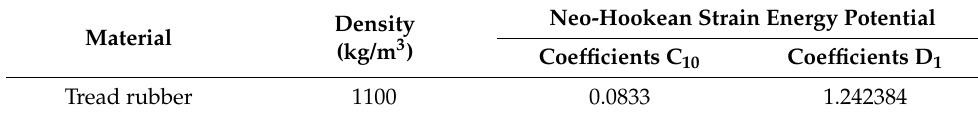
Table 1. Material property of tread rubber